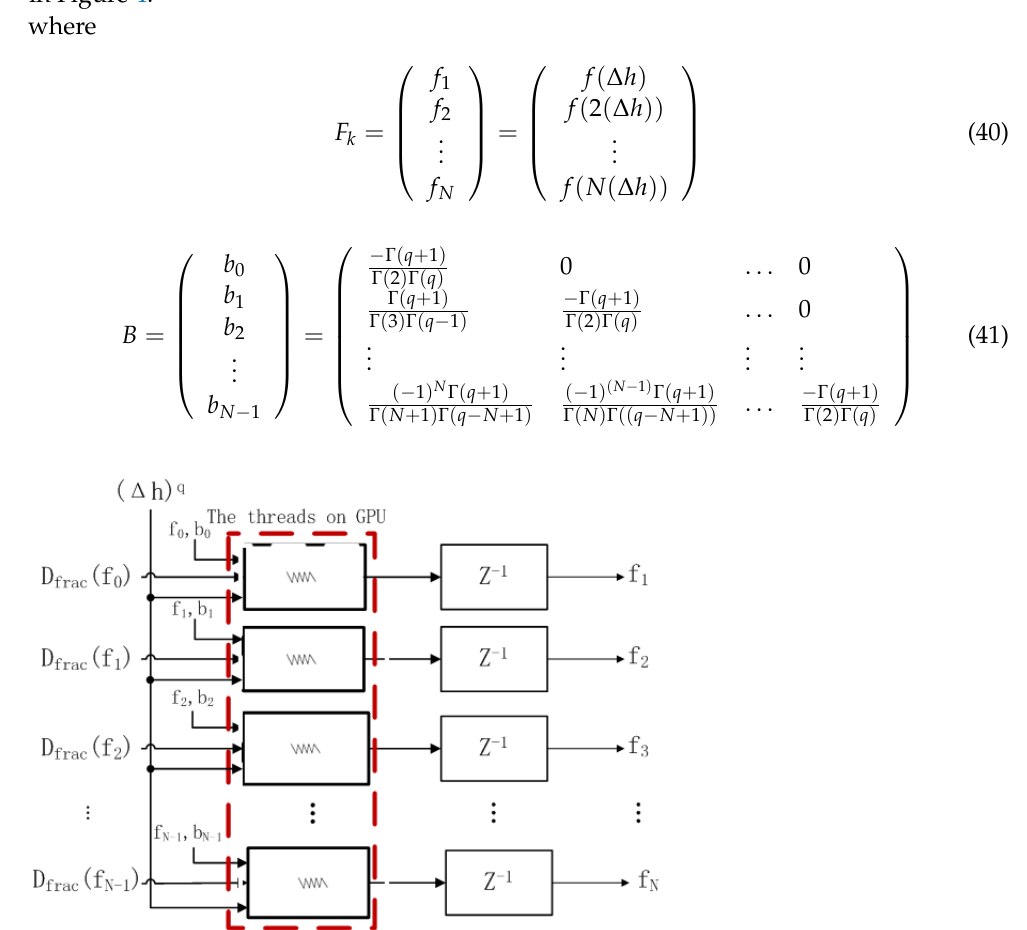
Table 2. The thread blocks of the proposed parallel model implemented on GPU. Figure No. Description Figure 4 The thread block of the proposed parallel model Figure 5 That of cold fluid for the counter-flow heat exchanger Figure 6 That of hot fluid side for the counter-flow heat exchanger Figure 7 That of cold fluid side for the parallel-flow heat exchanger Figure 8 That of hot fluid side for the parallel-flow heat exchanger The thread blocks of the proposed parallel model (2) implemented on GPU are shown in Figure 4.